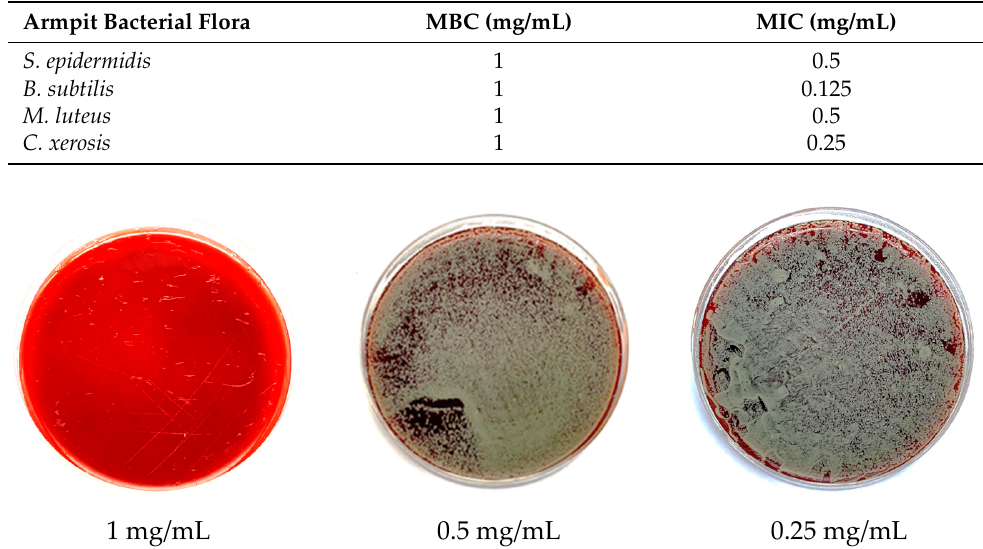
Figure 2. MBC of CD9 tetraspanin peptide against M. luteus on blood agar. Inhibition of bacterial biofilm by CD9 peptide showed that S. epidermidis was excel- lently inhibited, as the absorbance values decreased significantly from (0.120 ± 0.004) to (0.065 ± 0.003) in the presence of the CD9 tetraspanin peptide (Table 3). The optical density values of B. subtilis and C. xerosis (0.090 ± 0.003) and (0.083 ± 0.002) were significantly re- duced to (0.062 ± 0.003) and (0.061 ± 0.004), respectively, compared with the CD9 tetra- spanin-peptide-treated group. Conversely, M. luteus was resistant to the CD9 tetraspanin peptide and, therefore, showed a high absorbance value (0.080 ± 0.012) in the treated well, whereas it showed a lower value (0.073 ± 0.002) in the untreated well (Figures 3 and 4).